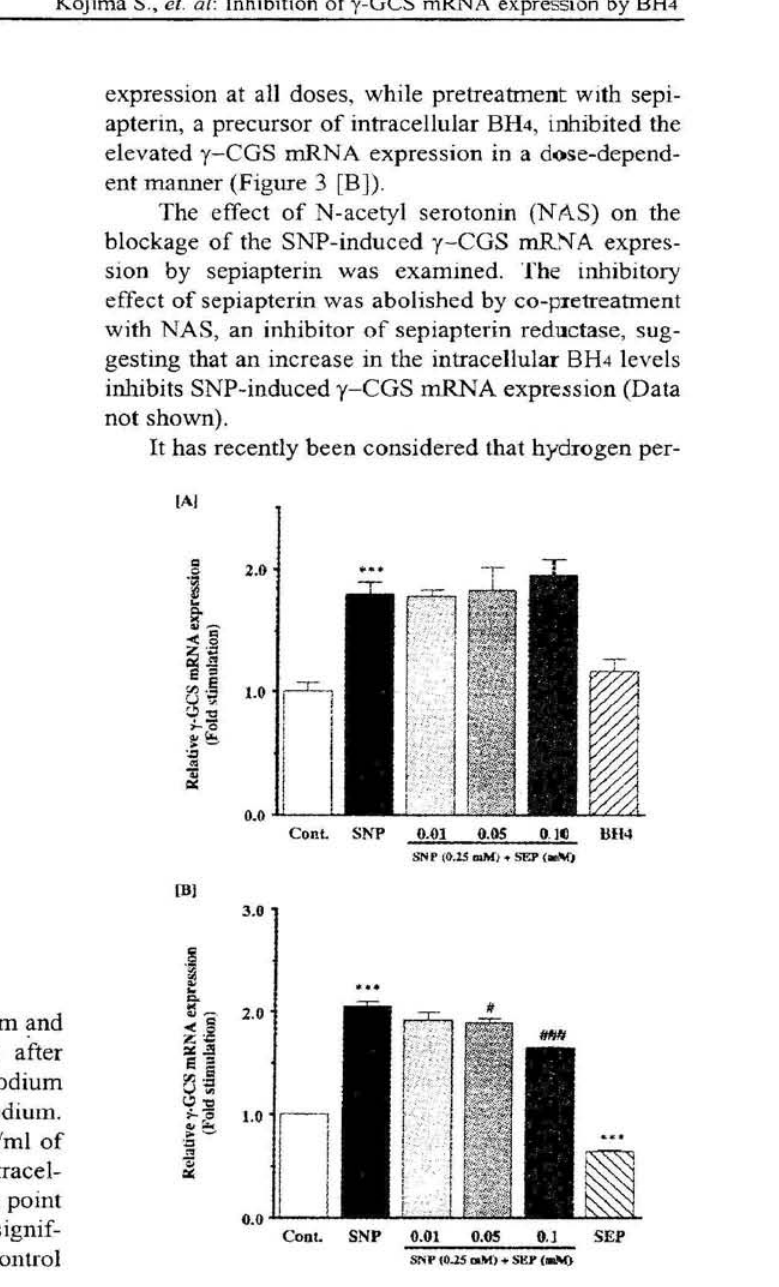
Figure 3. Effects of extracellular and the intracellular BH4 on γ-CGS mRNA expression induced by SNP treatment. RAW264.7 cells were incubated with 0.25 mM SNP in the presence of BH4 or sepiapterin for 3 h, and subjected to analysis of the gene expression. [A] Effect of exogenously added BH4 on γ—CGS mRNA expression; [B] Effect of sepiapterin on γ-CGS mRNA expression. Cont., non-trated control; SNP, sodium nitroprusside; SEP, sepiapterin. *** signifi- cantly different from each of the non-treated control groups at p<0.005. # and ### significantly different from SNP alone-treated group at p<0.05 and p<0.005,